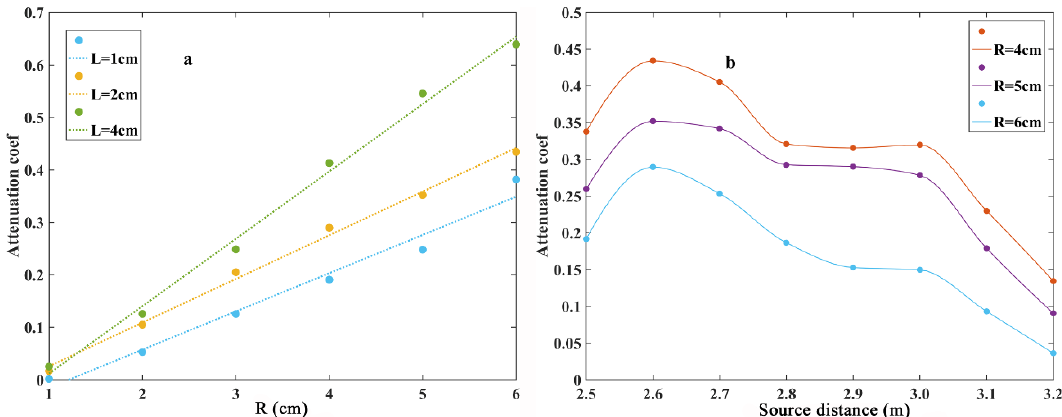
Figure 9. Effect of cave and source distance on attenuation coefficient of the S-wave. ( a) shows the effect of the cave radius on attenuation coefficient . ( b ) shows the effect of the source distance on attenuation coefficient. R represents the radius of the cave and L represents the distance of the cave to the borehole wall. Center frequency of source is 10 kHz.